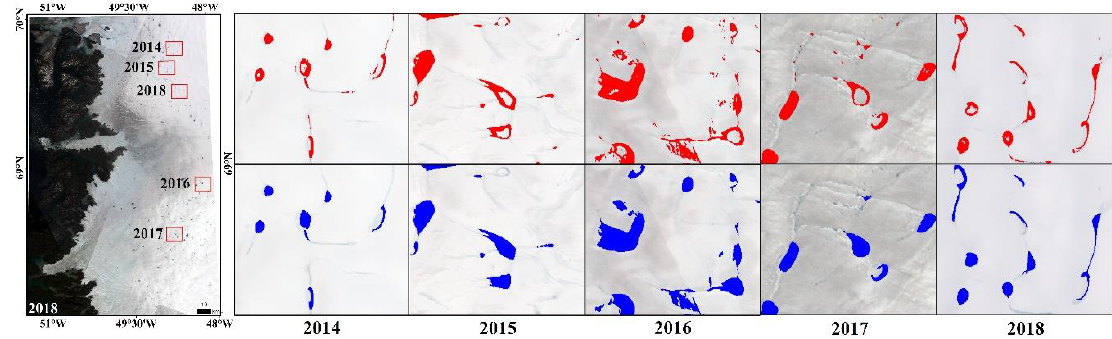
Figure 10. The comparison between identified water (red) and extracted SGLs (blue) during 2014 to 2018 (the left subfigure shows the locations of detailed frames in the five years). SGLs in southwest Greenland from 2014 to 2018 have been extracted successfully. As shown in Figure 11, the SGLs are mainly distributed in the northern and southern portions of the study region. Their appearances are most active in 2015 and 2016 in the southern and northern areas, respectively, and they both decreased afterwards.